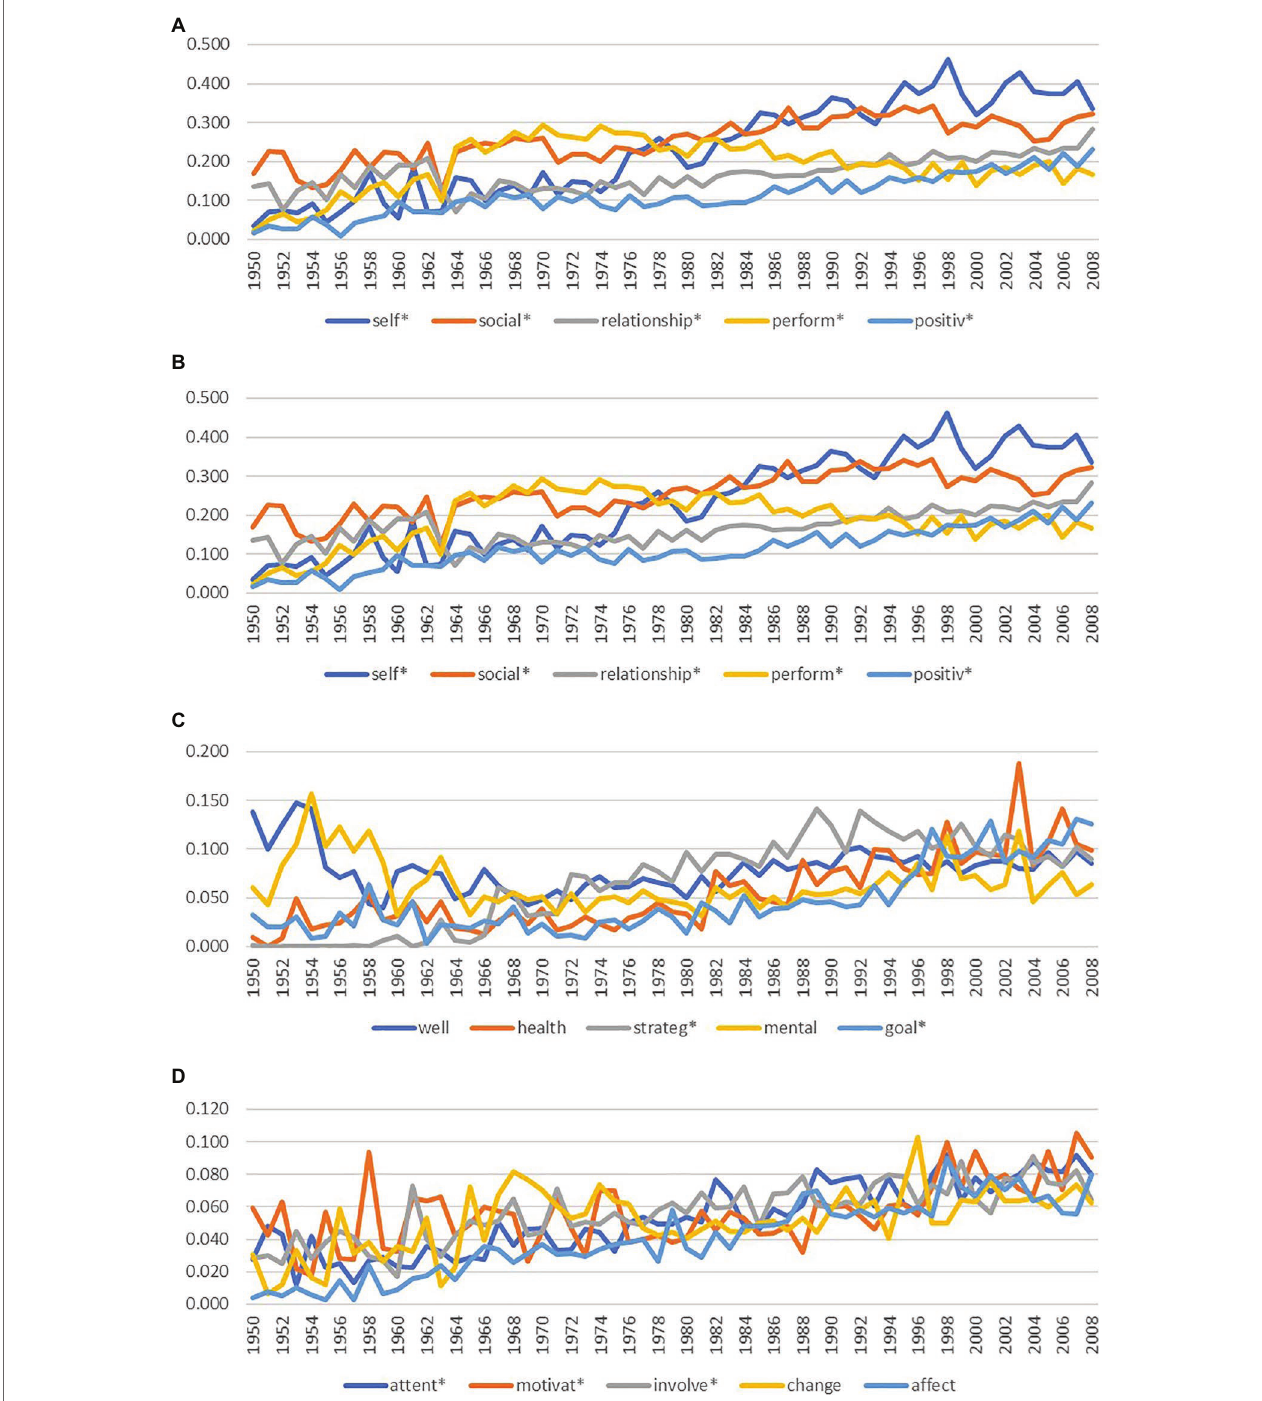
FIGURE 2 | (A) Time series of term prevalence for the top five most prevalent positive education terms, 1950–2008. (B) Time series of term prevalence for the 6th to 10th most prevalent positive education terms, 1950–2008. (C) Time series of term prevalence for the 11th to 15th most prevalent positive education terms, 1950–2008. (D) Time series of term prevalence for the 16th to 20th most prevalent positive education terms,